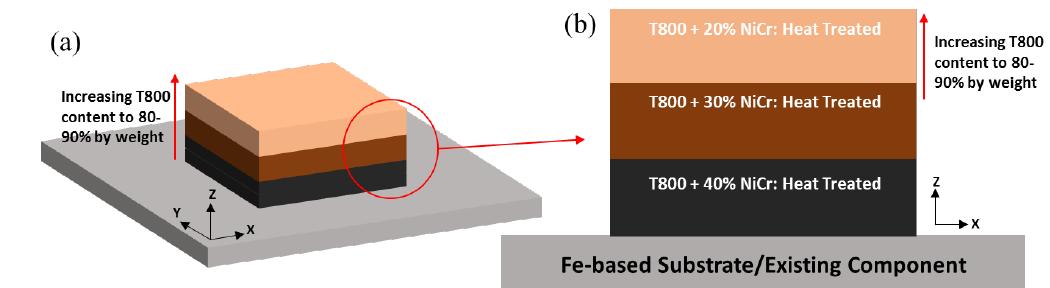
Figure 9. Compositionally graded fabrication strategy with T800 + NiCr alloy and intermediate heat treatment. ( a ) schematic 3D representation and, ( b ) detail cross section view.